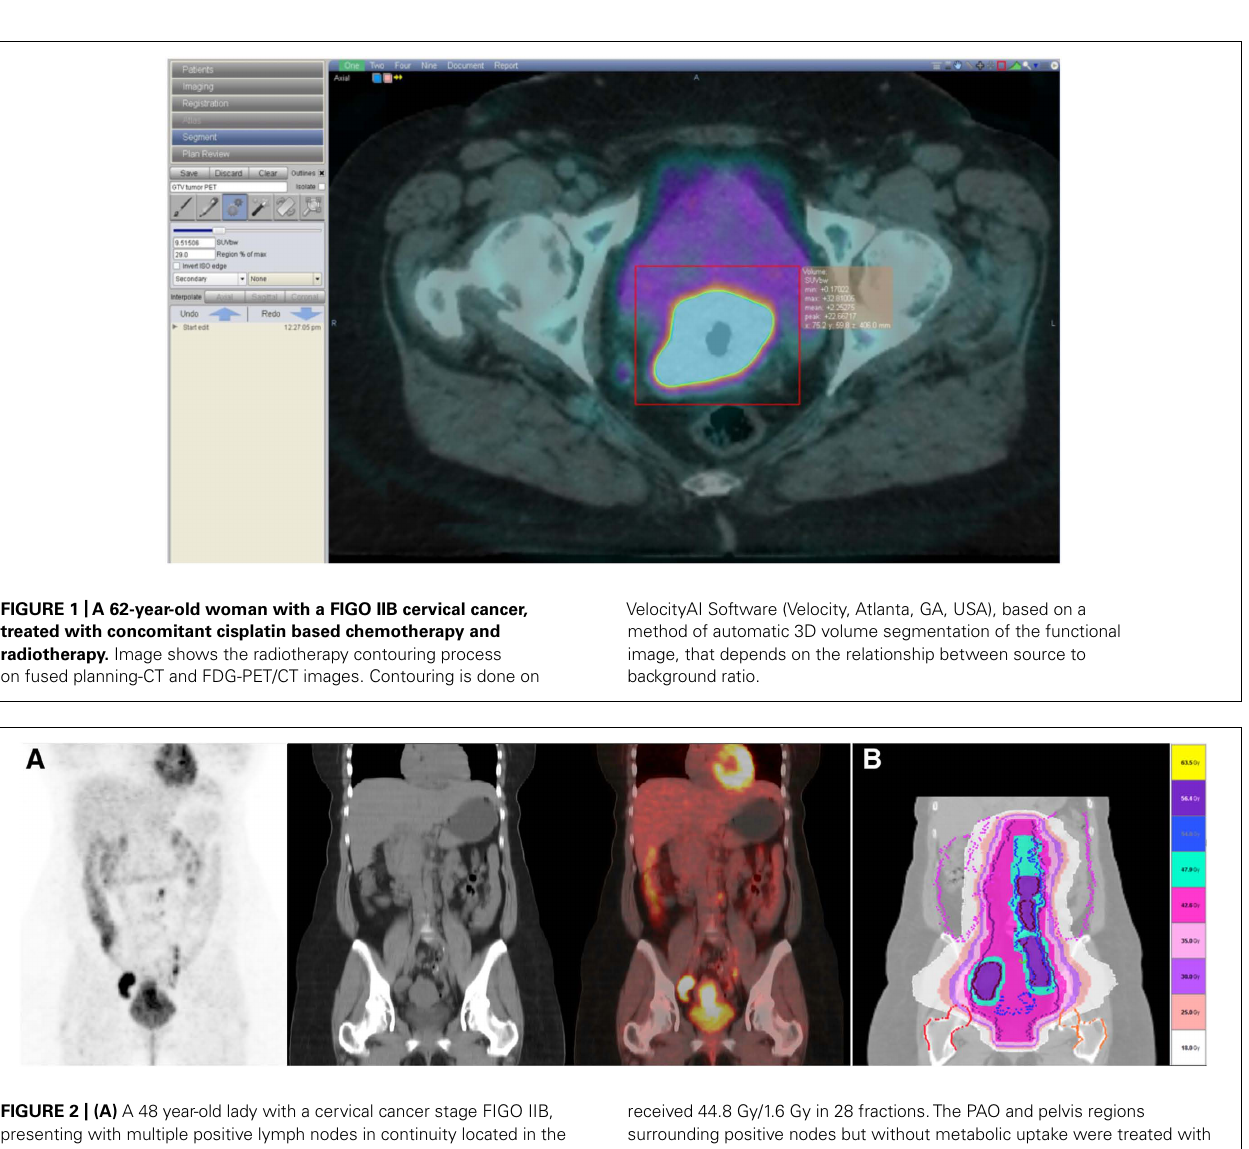
received 44.8 Gy/1.6 Gy in 28 fractions.The PAO and pelvis regions surrounding positive nodes but without metabolic uptake were treated with 50.4 Gy/1.8 Gy in 28 fractions. Positive FDG PET/CT lymph nodes were treated with a simultaneous integrated boost up to 59.36 Gy/2.12 Gy in 28 fractions. Scale dose banding shows the 95% of the